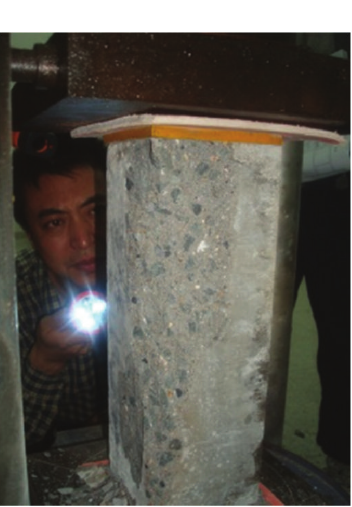
Figure 7: Prismatic heating jacket.